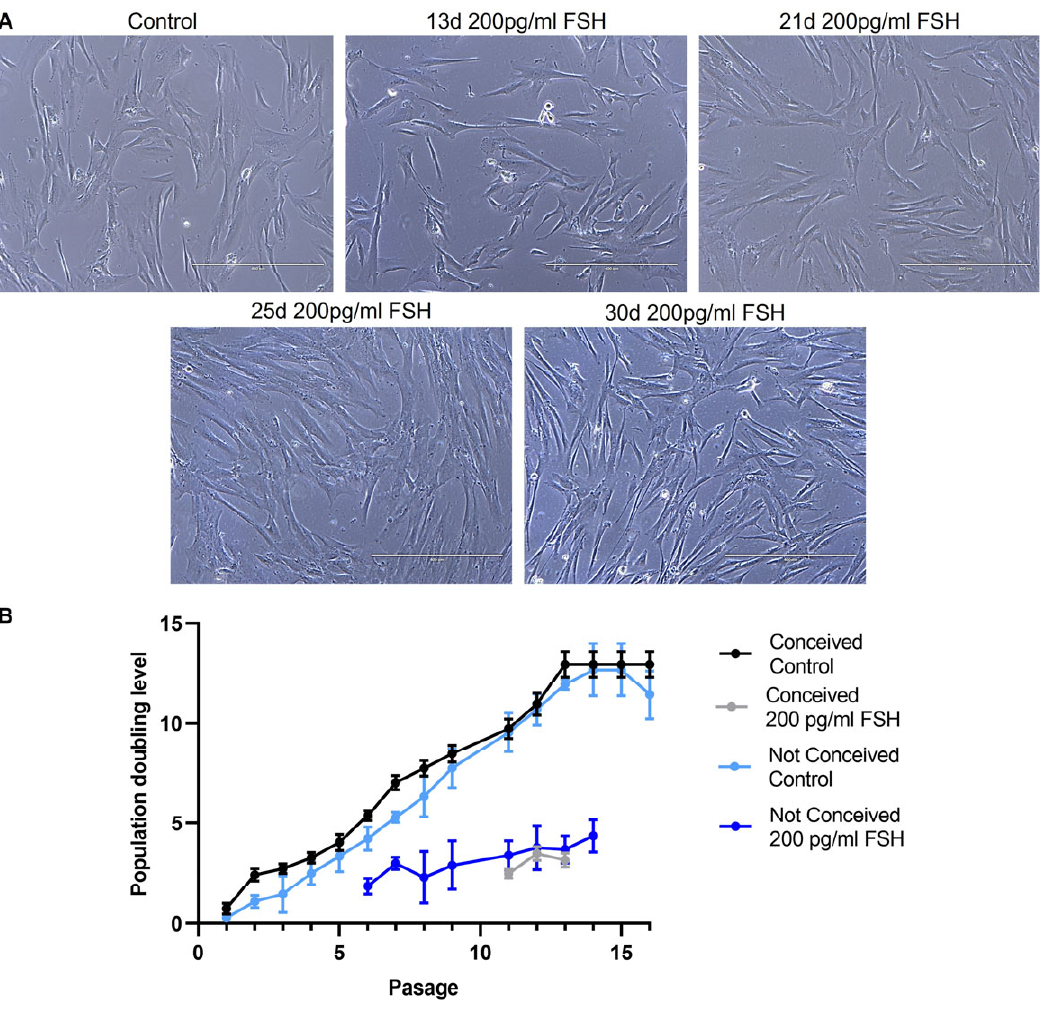
Figure 1. ( A ) FF stromal cell morphology. Control—untreated cells, 13d, 21d, 25d, 30d—cells after 13, 21, 25 and 30 days of culture in medium with 200 pg/mL FSH. Scale bar: 400 μ m (10× objective).; ( B ) Population doubling level of FF stromal cells , passage represents number of times the cells have been subcultured.